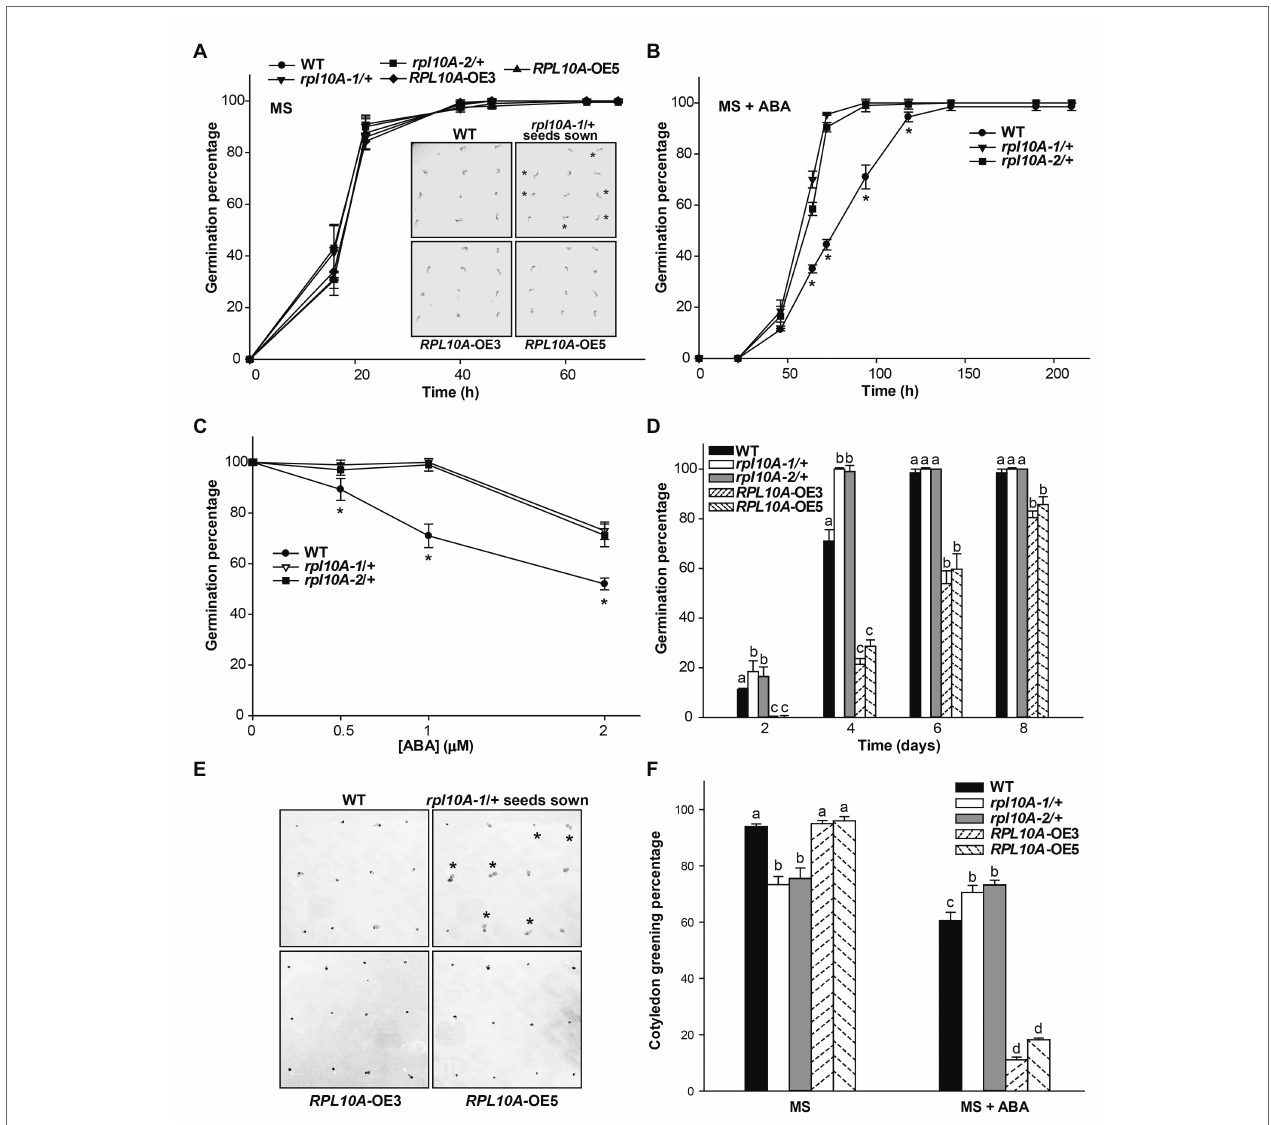
FIGURE 3 | Effect of exogenous ABA on germination and cotyledon greening of rpl10A/+ mutant and RPL10A -overexpressing seeds. (A) Germination percentage of wild type (WT), rpl10A-1/+ , rpl10A-2/+ , and RPL10A -overexpressing OE3 and OE5 seeds on MS-agar medium (MS). Inset: representative images of seedlings from all genotypes 1 day after stratification. Heterozygous rpl10A-1 mutant seedlings are indicated with asterisks. (B) Germination percentage of WT and rpl10A-1/+ and rpl10A-2/+ seeds on MS-agar medium supplemented with 1 μ M ABA (MS + ABA). Asterisks indicate statistical differences between WT and each mutant at each time applying Student’s t -test ( p < 0.05). (C) ABA concentration-dependent germination assay. rpl10A-1/+ , rpl10A-2/+ , and WT seeds were germinated on MS-agar medium supplemented with increasing concentration of ABA and the germination percentages were scored at 4 days after stratification. Results represent the average of three independent experiments ± SE ( n = 100 for each biological replicate). Asterisks indicate statistical differences between WT and each mutant at each time applying Student’s t -test ( p < 0.05). (D) Germination percentage of WT, rpl10A/+ mutants ( rpl10A-1/+ and rpl10A-2/+ ), and RPL10A -overexpressing seeds ( RPL10A -OE3 and RPL10A -OE5) on MS-agar medium supplemented with 1 μ M ABA at 2, 4, 6, and 8 days after stratification. Results represent the average of three independent experiments ± SE ( n = 100 for each biological replicate). Different letters over the bars indicate statistical differences between genotypes at each time using ANOVA test ( p < 0.05). (E) Representative images of WT, rpl10A-1/+ mutants, and RPL10A -overexpressing lines ( RPL10A -OE3 and RPL10A -OE5) grown on MS-agar medium supplemented with 1 μ M ABA (MS + ABA), at 4 days after stratification. Heterozygous rpl10A-1 mutant seedlings are indicated with asterisks. (F) Cotyledon greening percentage of WT, rpl10A/+ mutants ( rpl10A-1/+ and rpl10A-2/+ ), and RPL10A -overexpressing lines ( RPL10A -OE3 and RPL10A - OE5) grown on MS-agar medium (MS) or on MS-agar medium supplemented with 1 μ M ABA (MS + ABA), at 8 days after stratification. Results are the mean of three independent experiments ± SE. For each genotype and condition (MS or MS + ABA), different letters over the bars indicate statistical differences applying ANOVA test ( p <